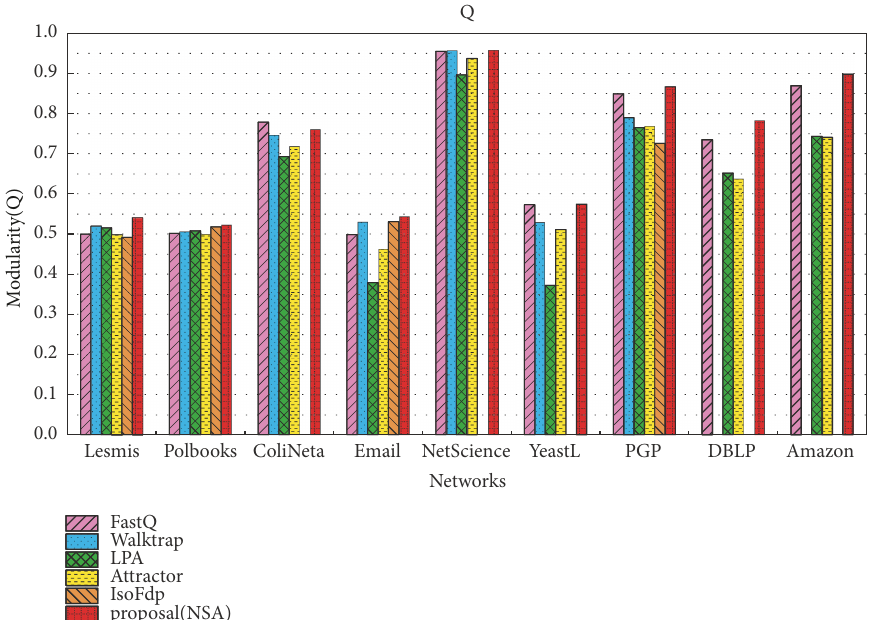
Figure 8: The bar chart of the modularity obtained by comparison algorithms and the proposed method, NSA.